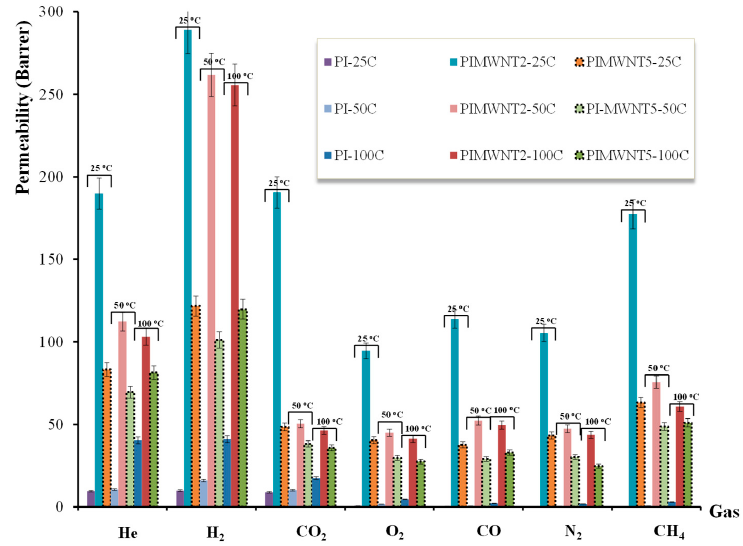
Figure 9. Permeability data of PI, PIMWNT2, and PIMWNT5 at 25, 50, and 100 °C for He, H 2 , CO 2 , O 2 , CO, N 2 , and CH 4 .